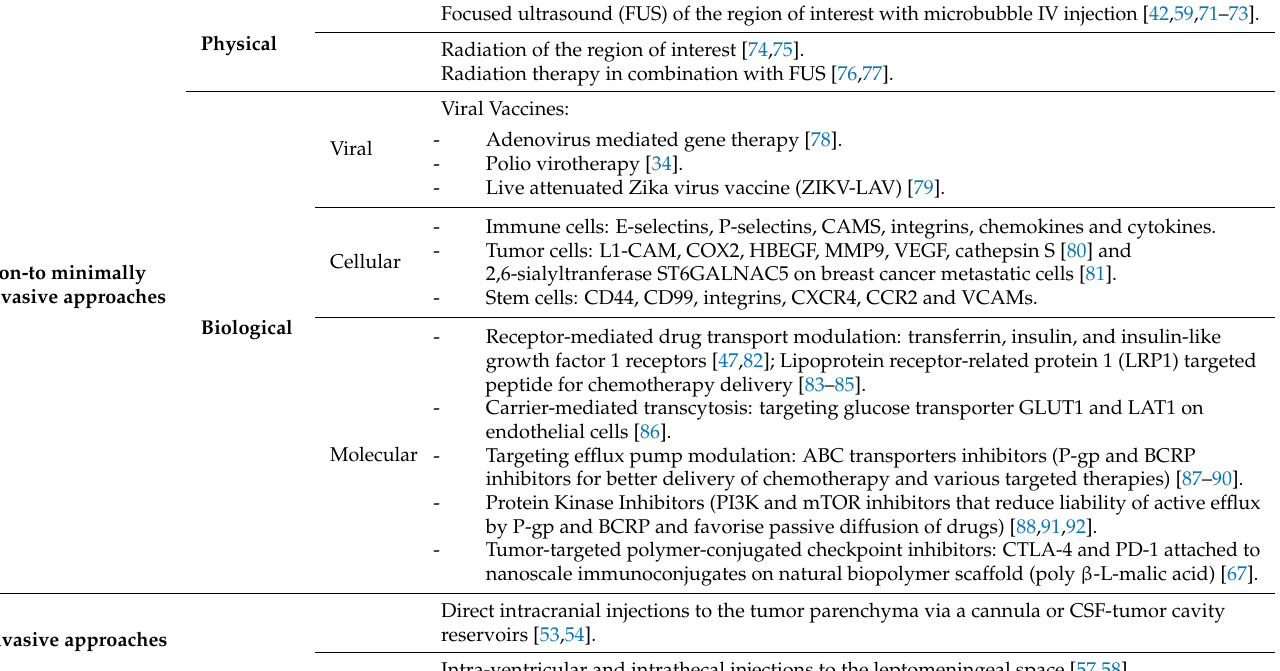
Table 1. Summary of non-invasive or minimally invasive to invasive approaches used to improve drug delivery across the BBB/BTB to brain